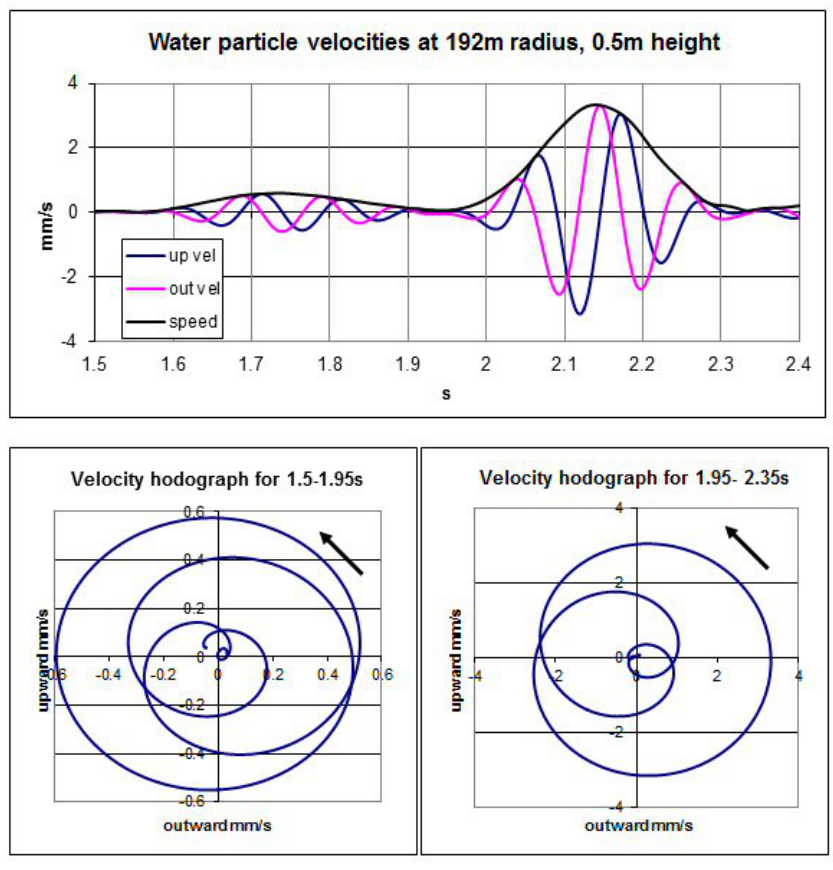
Figure 8. A time series from 1.5 s to 2.4 s shows an early mode that is less intense. The early mode data in Figure 8 was selected (1.5 s to 1.95 s) and plotted as a hodograph below the time series. This shows the locus of the motion of the water particle as the early mode passed. A second hodograph shows the data for the period 1.95 to 2.35 s, after a brief moment of